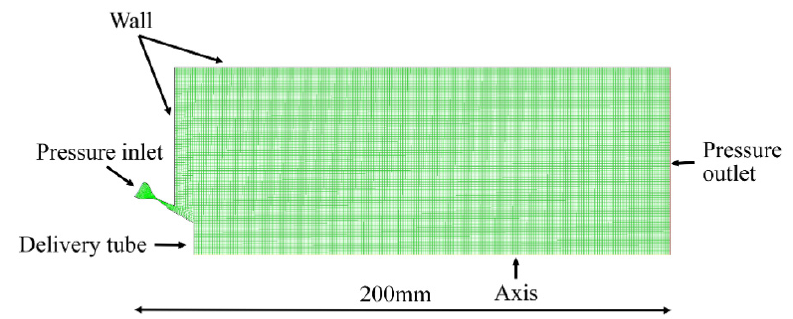
Figure 3. Geometry of computational domain and boundary conditions.